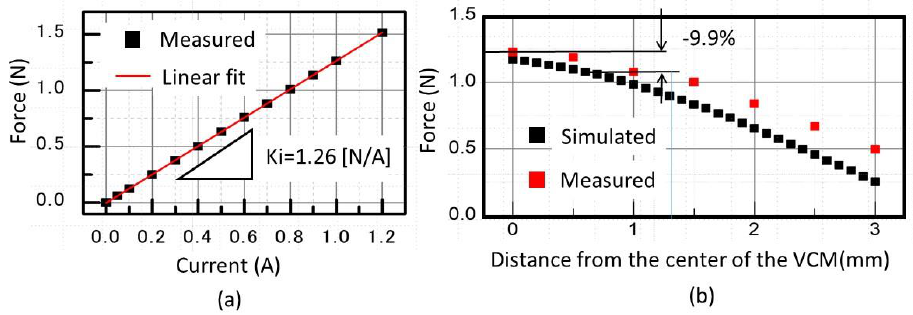
Figure 6. The VCM characteristics: ( a ) Measured current–force relationship of the designed VCM; ( b ) measured and simulated force at each position with a current density of 5.4 mm 2 / A in the VCM coil.